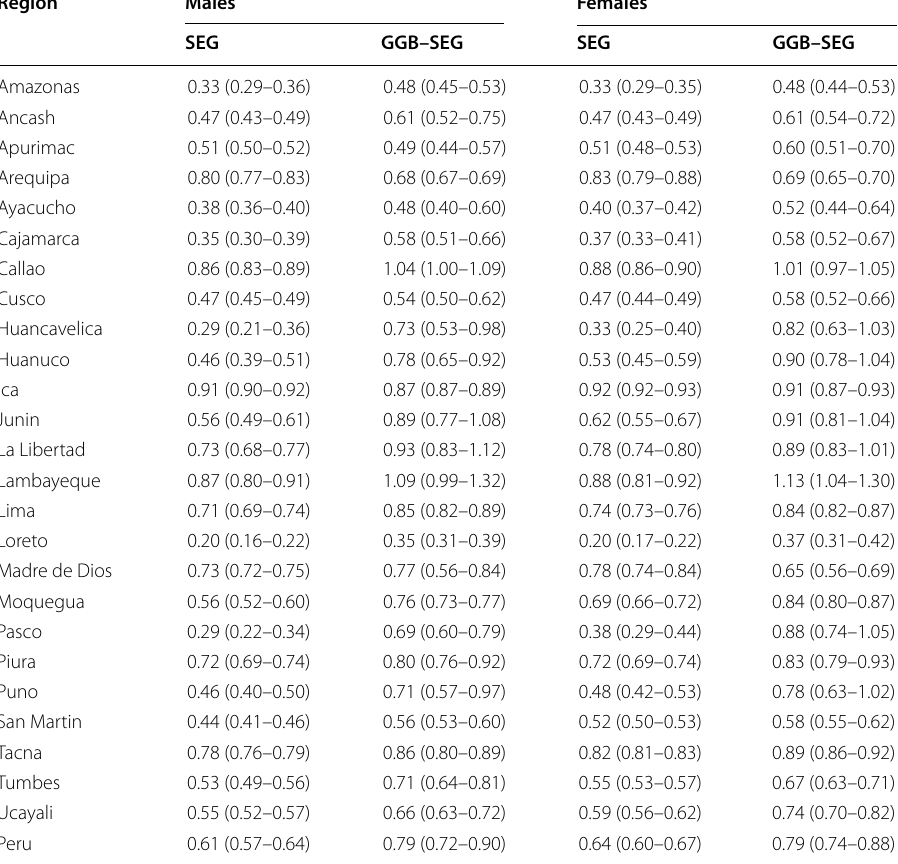
Table 4 Estimated death registration completeness for adult deaths with the two-census SEG and combined GGB–SEG methods in Peru and its